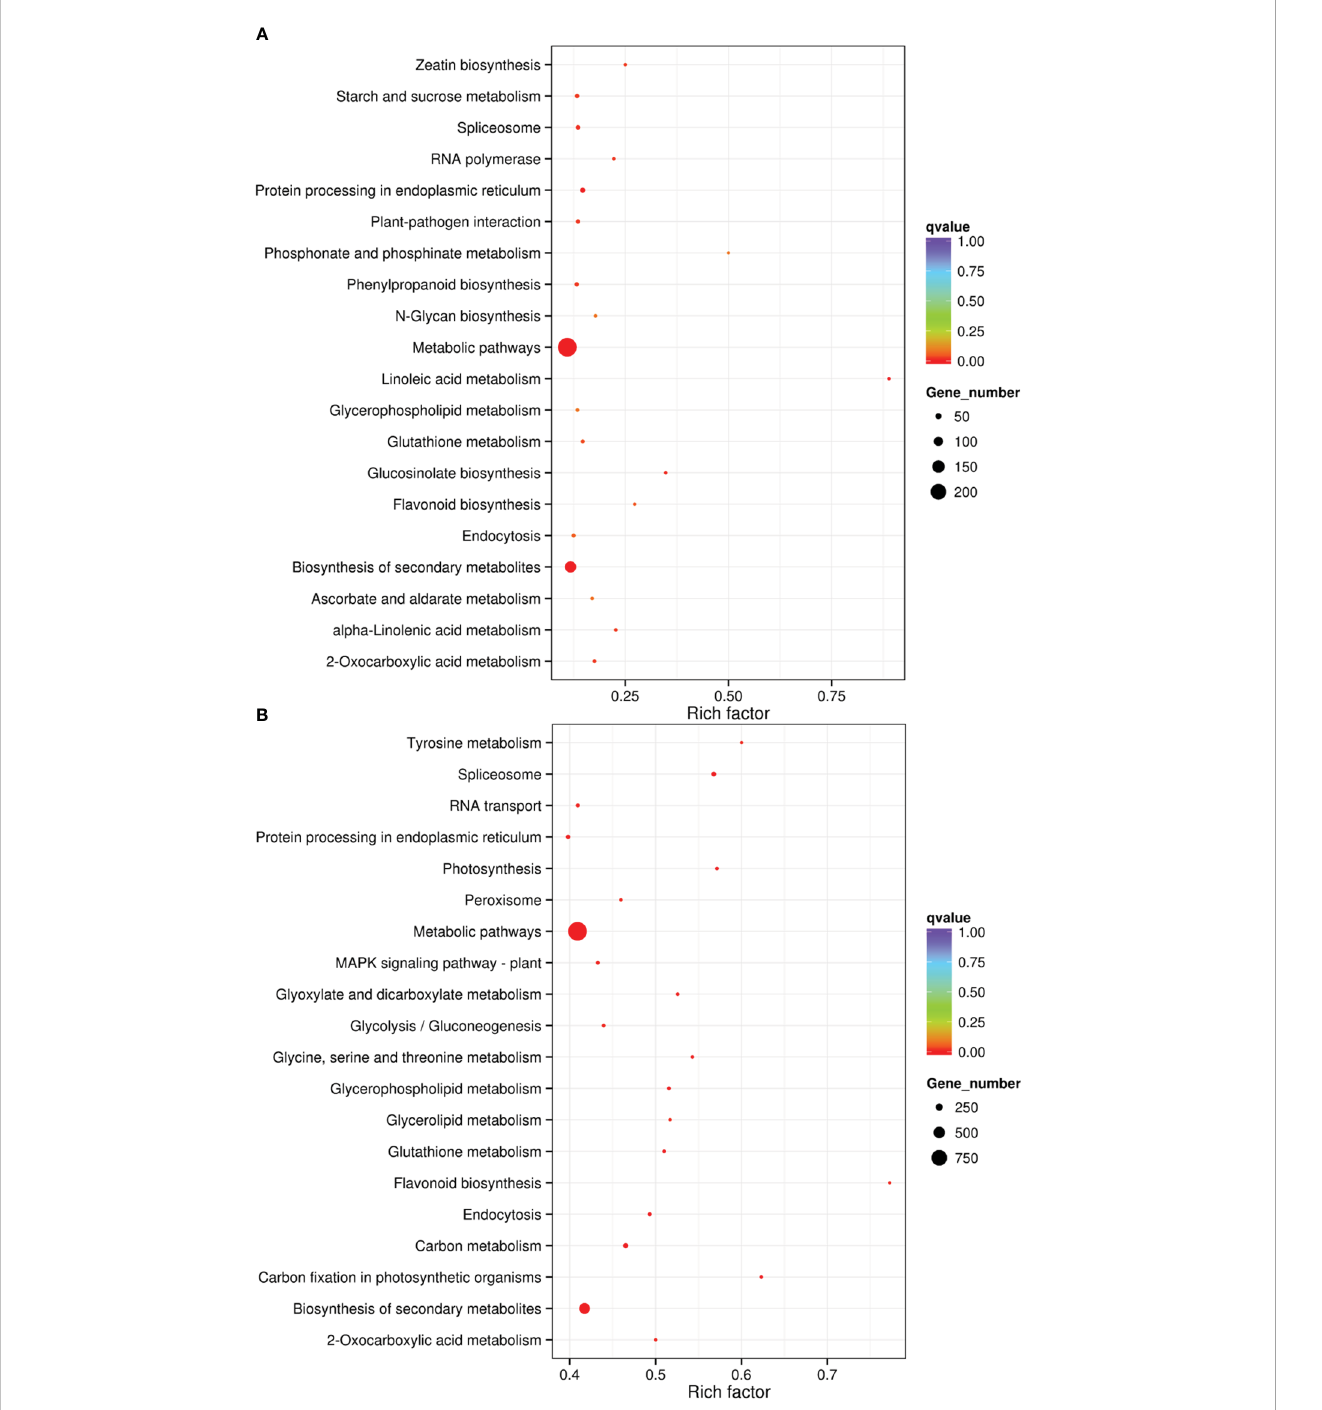
FIGURE 6 KEGG analysis of the predicted target genes for DElncRNAs. (A) KEGG pathways for cis- target genes. (B) KEGG pathways for trans-target